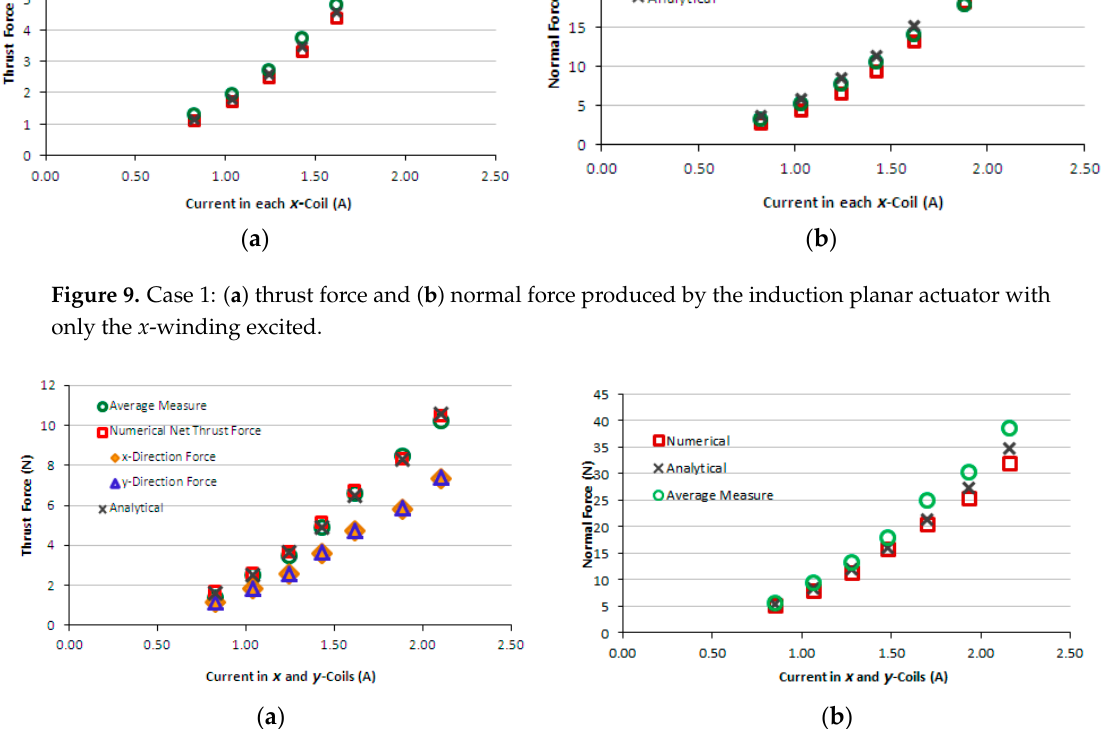
( b ) Figure 12. Case 2: ( a ) thrust force and ( b ) normal force produced by the induction planar actuator when both x and y -winding are under current.